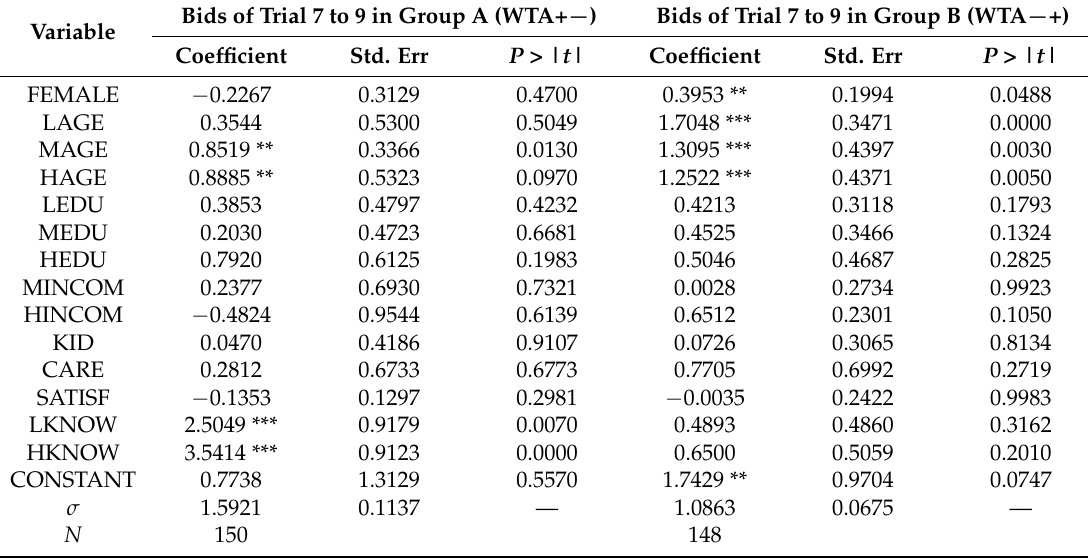
Table 9. Parameter estimation results for two types of information